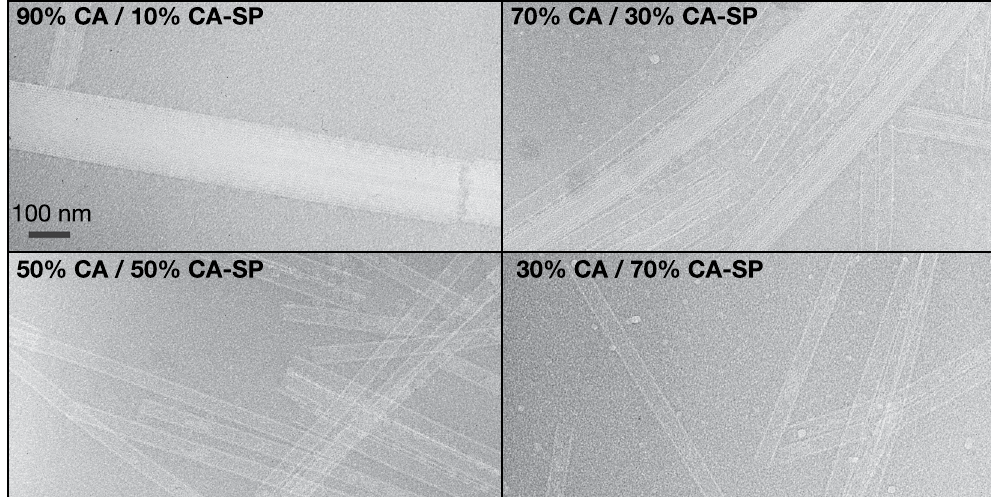
Figure 7. Cryo-EM images of tubes assembled from RSV CA/CA-SP mixtures. Images of typical tubes assembled from RSV CA/CA-SP mixtures at the indicated relative composition. To assemble the tubes CA/ CA-SP mixtures (total protein concentration 570 μ M in standard pH 7 storage buffer) were incubated at 37 °C for several days, before cryo-EM data collection.